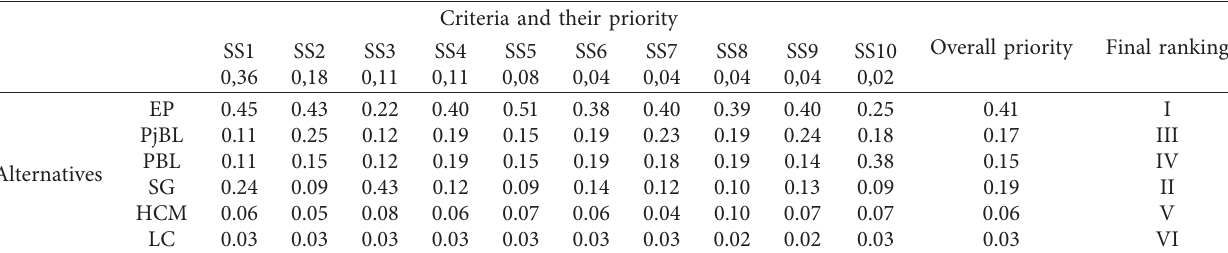
Table 19: Overall priority vector and learning strategies